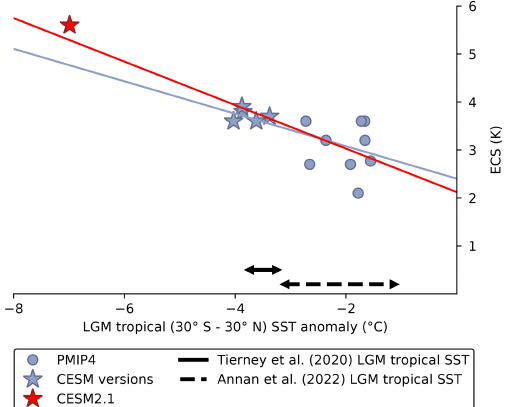
Figure 14. Emergent constraint between tropical (30 ◦ S–30 ◦ N) LGM SST anomaly and ECS in the PMIP4 ensemble with the addi- tion of several CESM model family versions. The constraint is com- pared between the presence (red) or absence (blue) of CESM2.1. The ECS of CESM2.1 is 5.6K, estimated from abrupt2 × CO 2 in slab ocean mode (Zhu et al., 2021), for comparison with the other CESM versions. The LGM tropical SST reconstructions of Tierney et al. (2020) and Annan et al. (2022) are